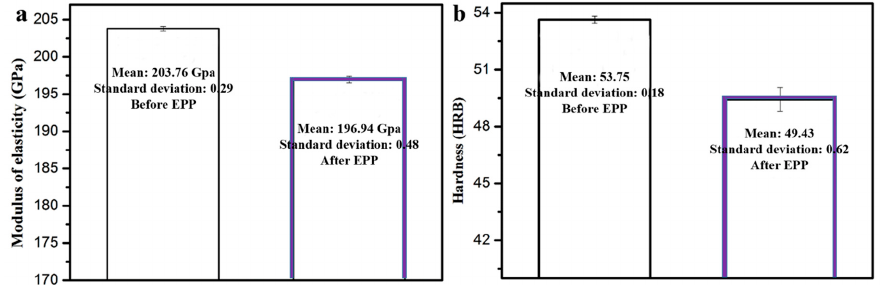
Figure 7. ( a ) Elastic modulus histogram of Q195 carbon structural steel ( b ) Hardness histogram of Q195 carbon structural steel. (Before EPP: black curve ; after 40 s EPP treatment: purple curve ).